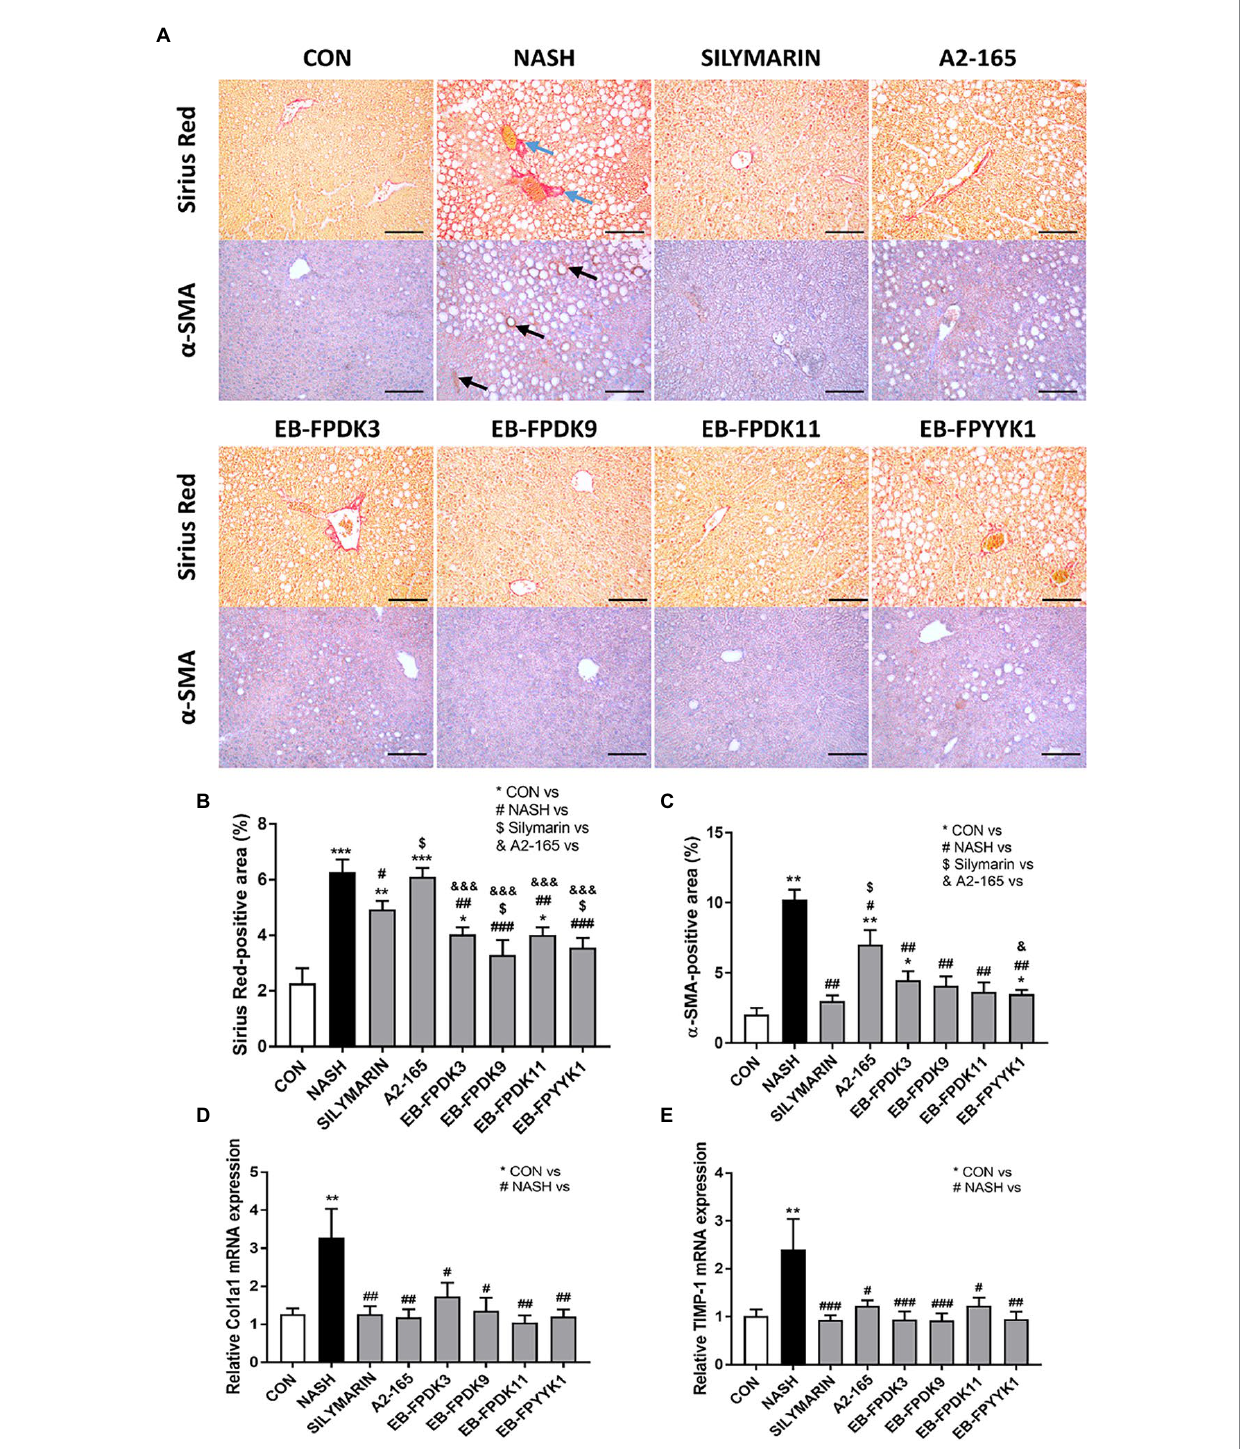
FIGURE 5 Faecalibacterium prausnitzii prevents the development of fibrosis in the liver. (A) Microscope images of Sirius Red- and α -SMA-stained liver tissues for immunohistochemistry assays. Scale bar: 0.1 mm. (B,C) Areas stained positive for Sirius Red and α -SMA in the liver. mRNA levels of hepatic fibrosis markers (D) Col1a1 and (E) TIMP-1. The data are presented as the mean ± SEM ( n = 12). Statistical analyzes were performed using the Mann–Whitney U test (two-tailed) ∗ p < 0.05, ∗∗ p < 0.01, ∗∗∗ p < 0.001 versus the CON group; # p < 0.05, ## p < 0.01, ### p < 0.001 versus the NASH group; $ p < 0.05 versus the silymarin group, & p < 0.05, &&& p < 0.001 versus the A2-165 group. α -SMA, alpha-smooth muscle actin; Col1a1, collagen type 1 a 1;